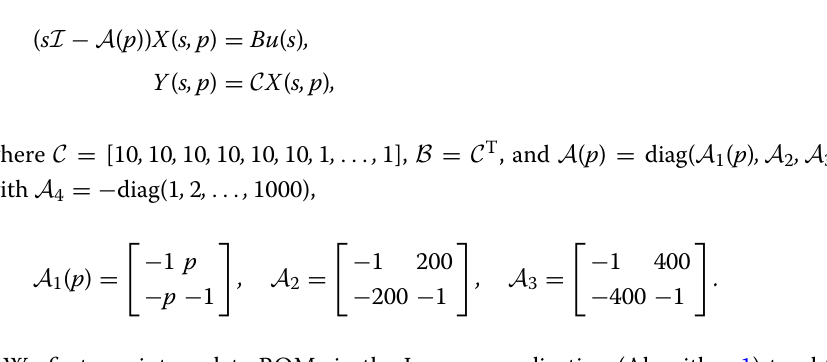
In this example, the ROMs are of the form (4) with complex E , A , B and C . Since E is nonsingular, we left multiply the system by E − 1 , which is of the reduced dimension, to obtain the system of the form (11), for which the pole-residue realization is